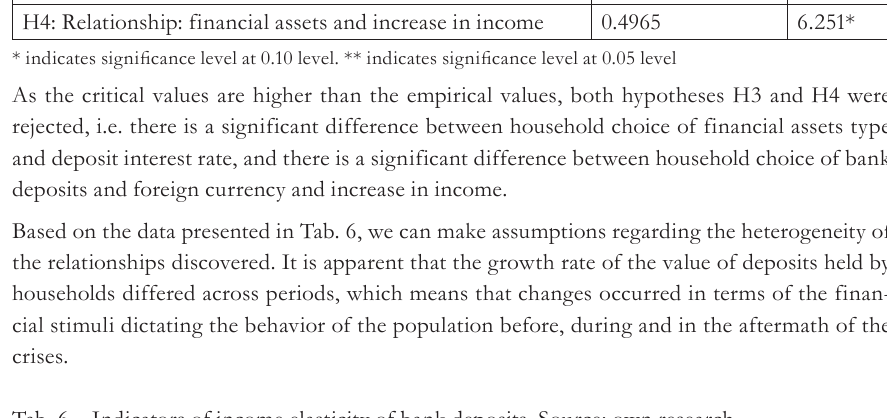
Tab. 6 – Indicators of income elasticity of bank deposits. Source: own